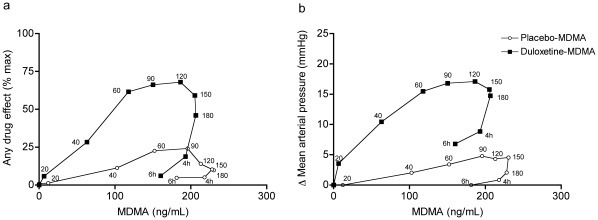
Pharmacokinetic-pharmacodynamic (PK-PD) relationship.MDMA effects are plotted against simultaneous MDMA plasma concentrations (a, b). The time of sampling is noted next to each point in minutes or hours after MDMA administration. The clockwise hysteresis indicates acute tolerance to the effects of MDMA. Duloxetine pretreatment markedly reduced physical and subjective responses to MDMA in the hysteresis loops (a, b).